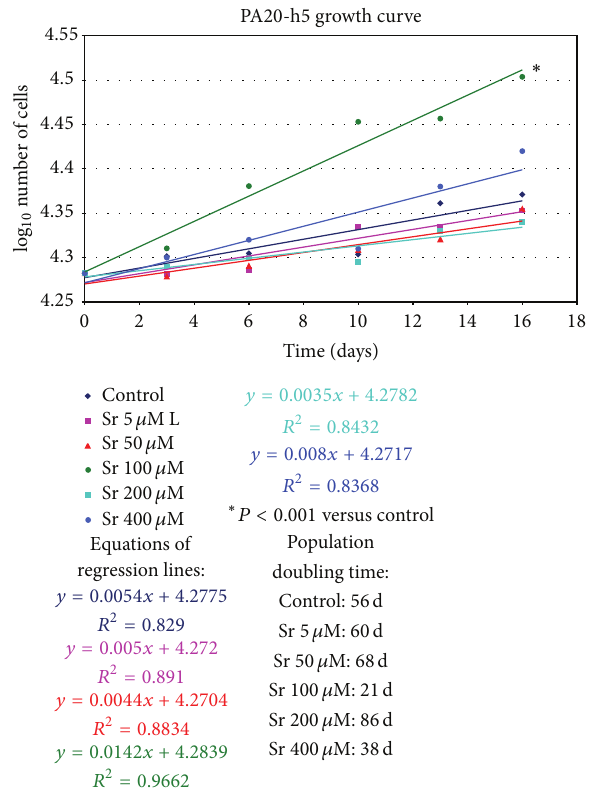
Figure 3: Graphical representation in linear regression of the kinetics of growth for PA20-h5 line cultured in Coon’s medium + FCS 1.5% in the presence of Sr 2+ concentrations from 0 to 400 𝜇 M. The equation and the 𝑅 2 value are reported for each straight line. Experiments are carried out in triplicate and are representative of three different